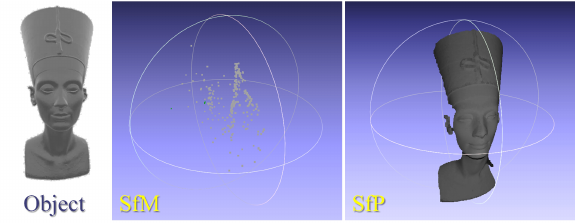
Figure 1. 3-D reconstructions using SfM and SfP-based models. Despite using 50 images, the SfM could not effectively extract and match object surface features. In contrast, the SfP completely reconstructed this specular featureless